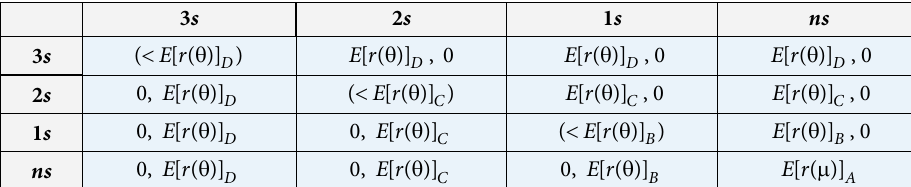
Table 1. Technological transition game with signals on X k , k = 1,